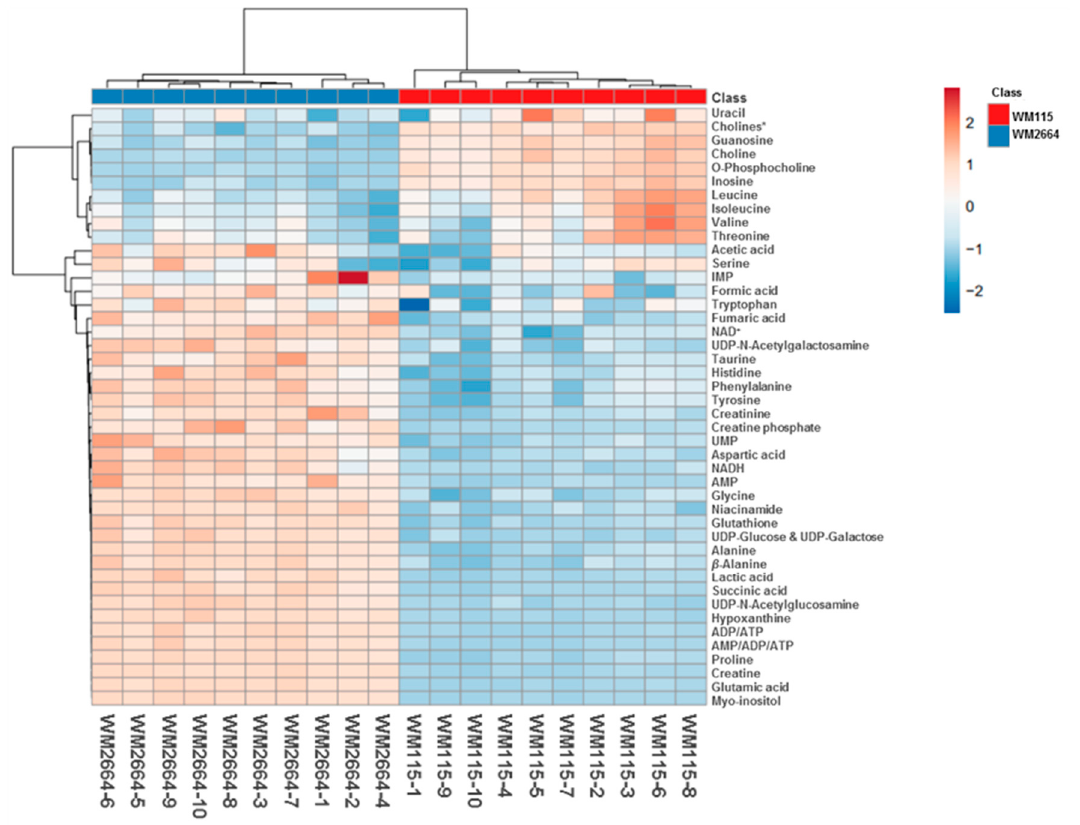
Figure 4. Presentation of NMR-identified, melanoma-derived, metabolites, in a heatmap form. * O-Acetylcholine and sn-Glycero-3-phosphocholine.